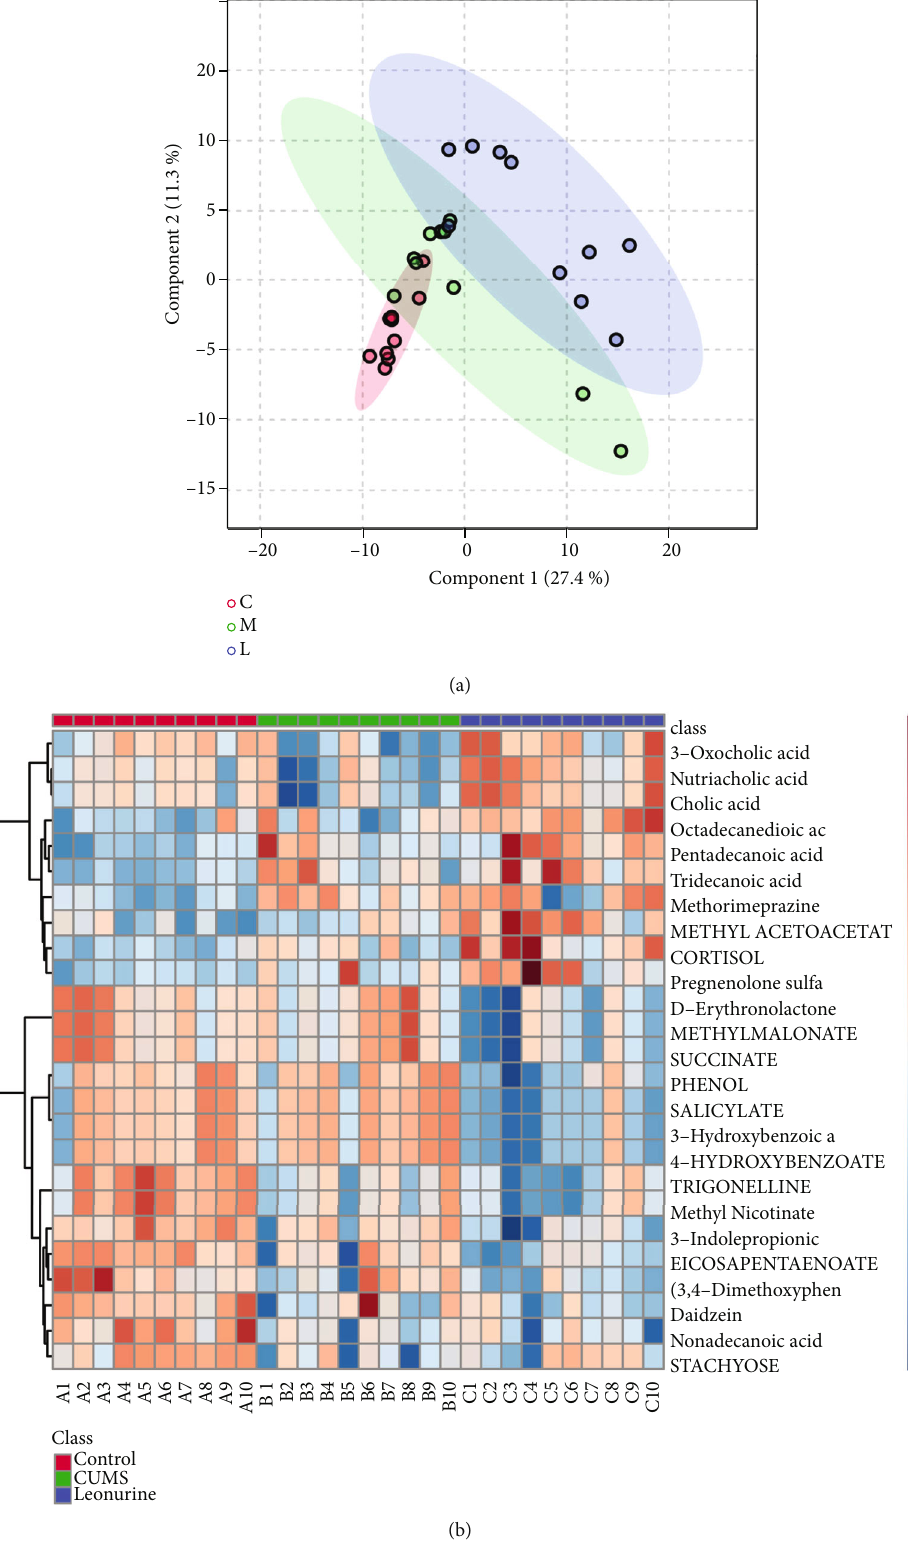
Figure 5: The e ff ects of leonurine on microbial metabolites in CUMS rats. (a) PLS-DA analysis of metabolic pro fi le changes. (b) Heat map showed the metabolic pro fi les of rats in Control, CUMS, and Leonurine